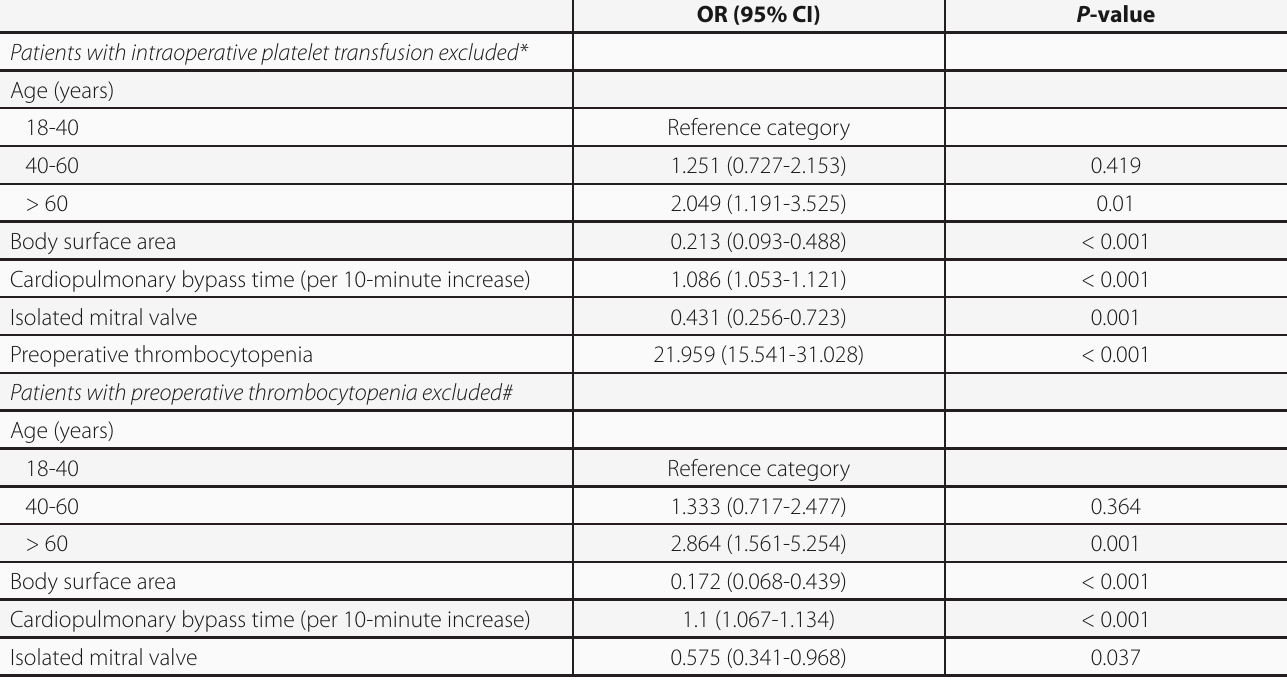
Table 5. Sensitivity analysis of multivariable analysis for postoperative thrombocytopenia.